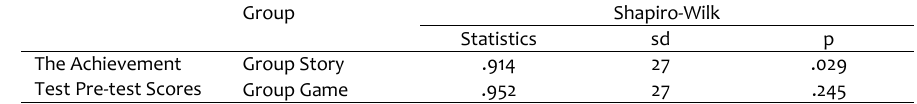
Table 2. Shapiro-Wilk Test results related to the Achievement Test pre-test scores